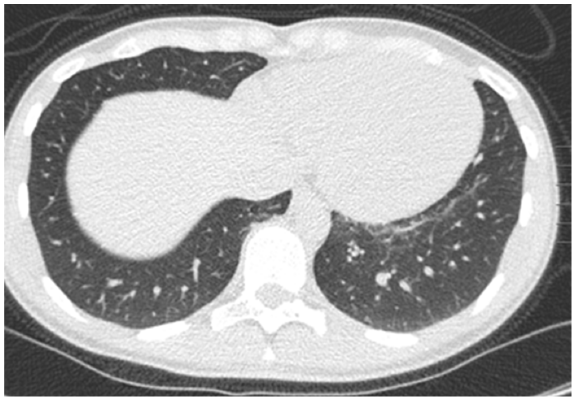
Figure 2. Baseline chest CT of a 27-year-old athlete. Confluent ground-glass opacities, pulmonary infiltrates.